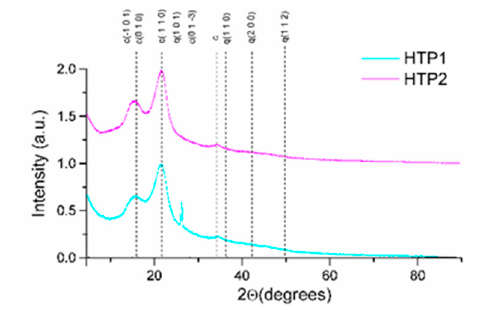
Figure 1. X-ray Diffraction analyses of the solid phase resulting from the hydrothermal conversion process, associated with the hydrothermally treated samples at 180 °C (HTP1) and at 200 °C (HTP2)